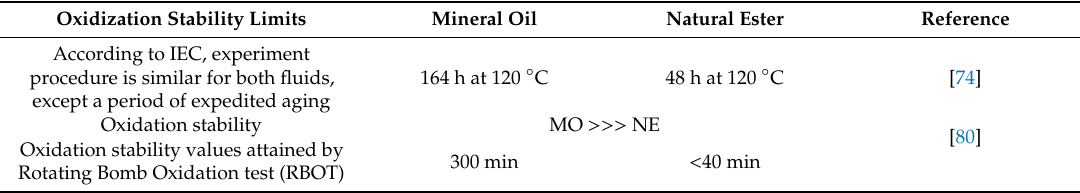
Table 15. Oxidization stability limits for various insulating